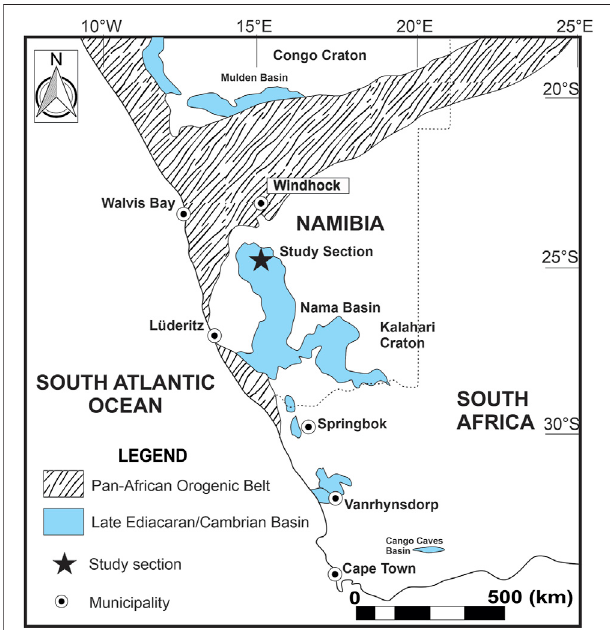
FIGURE 2 | Map of the Precambrian expositions in Namibia and the studied area positioning (after Gaucher et al., 2005).